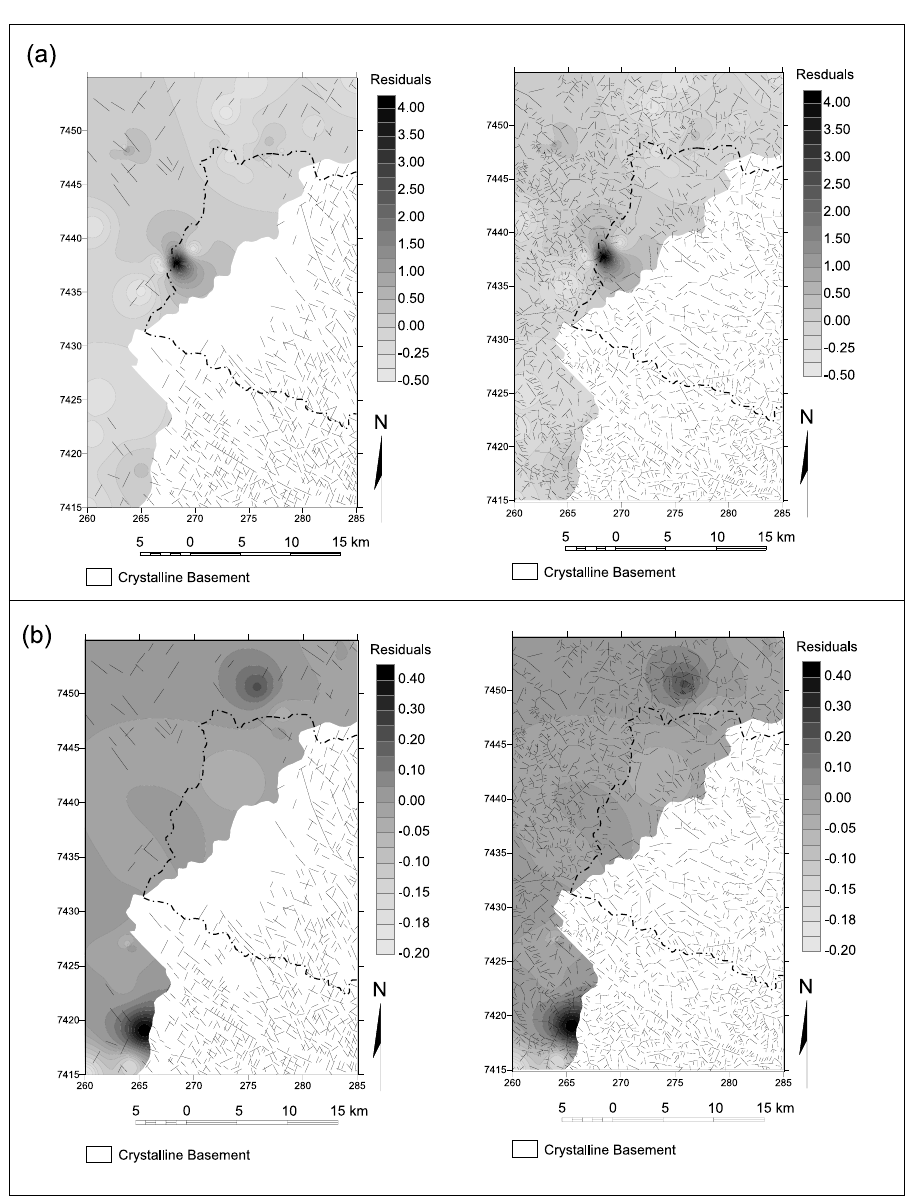
Fig. 5 – Residual maps of specific capacity of wells that exploit (a) the Tubarão Aquifer System and (b) both aquifers, besides the lineaments traced from the radar images in 1:250.000 scale and the aerial photography in 1:60.000 scale.